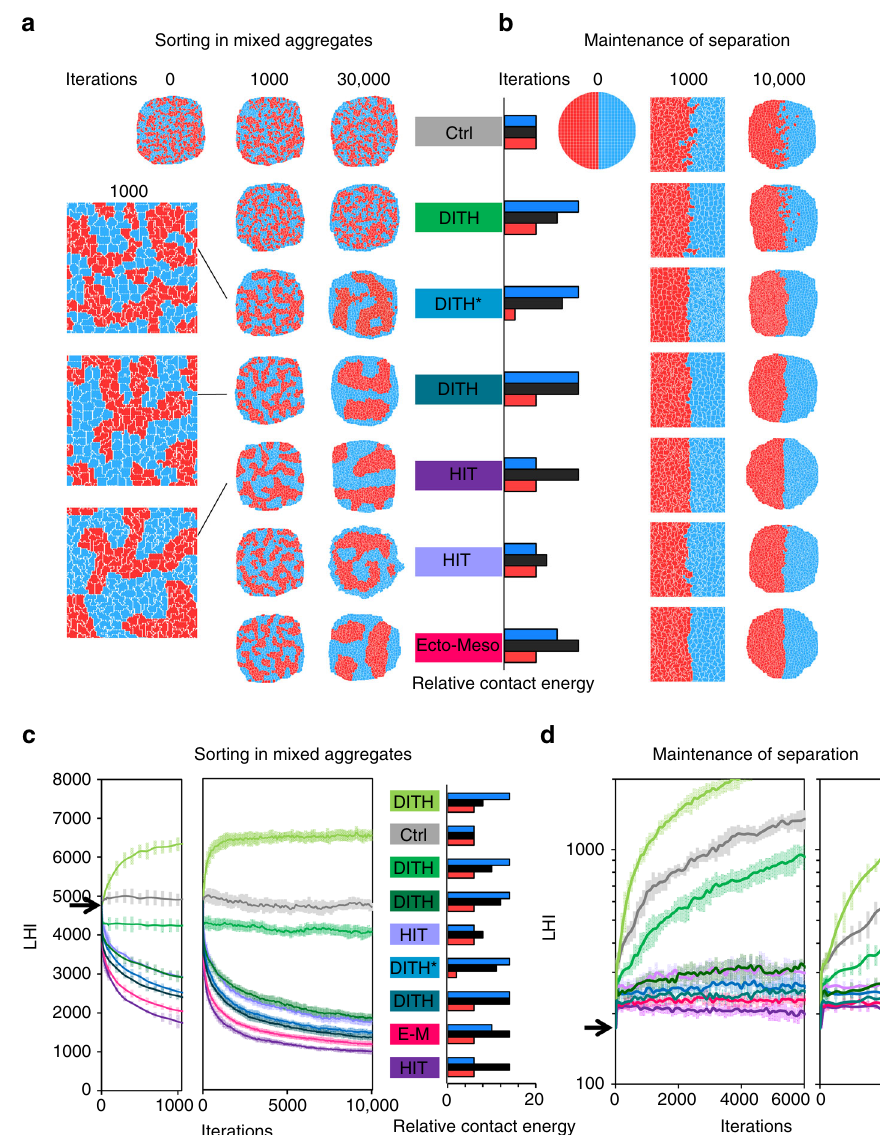
Fig. 6 Model simulations of cell sorting and tissue separation. Simulations of sorting from a mixed aggregate ( a , c ) and of maintenance of a boundary interface ( b , d ). a , b Representative snapshots at the indicated number of iterations. Rectangular images represent enlargements of a portion of the aggregates. Initial matrices are shown at 0 iteration. c , d Evolution of LHI used as an index for cell sorting and for maintenance of separation. Small panels show details of the fi rst 1000 iterations. The curves represent the average of 15, respectively, 8, independent simulations. Error bars: s.d. In the case of mixed aggregates, each simulation started from a different initial matrix of randomly distributed cells. The same sets of relative contact energies were used for both types of situations. DITH scenarios differ in terms of the relative heterotypic interfacial energy, set at 25, 50, 75 and 100% of the difference between the homotypic tension energies of the two cell populations. DITH* corresponds to the previously published conditions 37 ; HIT conditions were set with identical homotypic energies in both cell types, and a higher interfacial tension; ectoderm – mesoderm ( E – M ) energies were based on estimated relative tensions in the Xenopus system. Cell to medium values were set as follows: a , b 25 for both cell types, all conditions. In graphs c and d , unequal values 18/9 for all conditions except for the two HIT conditions, where they were set equal, respectively, 9/9 and 18/18. Varying cell to medium values had little impact on sorting and separation (see systematic comparisons in Supplementary Fig. 8b –